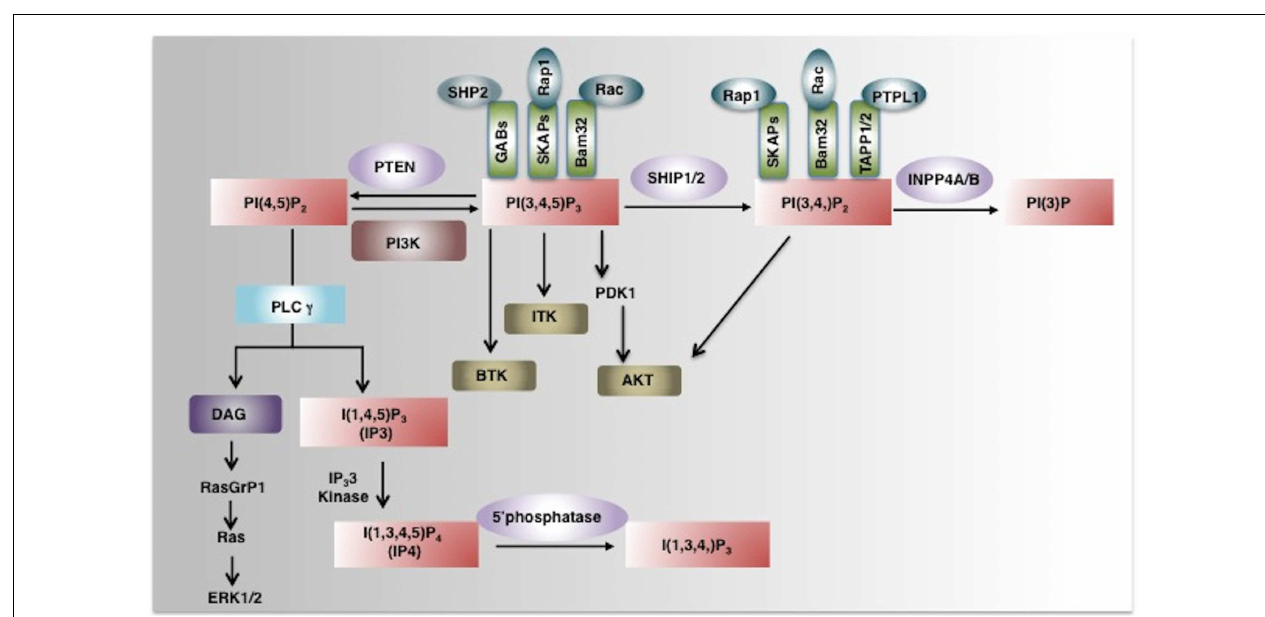
PI(3)P by removal of the phosphate at the 4-position of the inositol ring. PI(3,4,5)P 3 and/or PI(3,4)P 2 enable recruitment to the plasma membrane of several PH-domain containing proteins including PDK1, AKT, BTK, ITK, and thus regulate pivotal cellular processes including activation, proliferation, and survival. PH-domain containing adaptor proteins (GABs, SKAPs, Bam32, andTAPP) can also bind to phosphoinositides and regulate cell signaling (indicated as green boxes). AKT, Protein Kinase B; PDK1, phosphoinositide-dependent kinase-1, PLC γ phospholipase C γ ; ITK, IL-2-inducibleT cell kinase) and BTK, Bruton agammaglobulinemia tyrosine